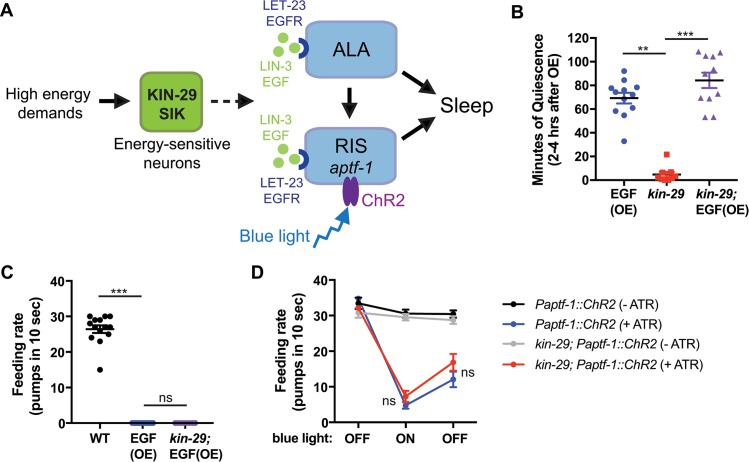
kin-29 acts upstream of ALA and RIS neurons to regulate sleep.(A) Model by which kin-29/SIK functions in energy-sensitive sensory neurons upstream of the sleep-promoting RIS and ALA neurons. ALA and RIS activation by LIN-3/EGF or RIS activation by ChR2 bypasses the requirement for KIN-29 function in sleep. RIS is also required for movement quiescence during SIS (see S11C–S11F Fig and [43]). (B and C) kin-29 null mutation does not affect the body movement quiescence (B) and reduced feeding rate (C) observed in response to EGF OE (n > 10 animals). To induce EGF OE, adult animals expressing a Phsp-16.2::LIN-3C transgene were heat-shocked for 30 min, 2 hr prior to analysis of behavior (see Material and methods). Data are represented as mean ± SEM. *** and ** indicate corrected p-values that are different from WT or kin-29 mutants at p < 0.001 and p < 0.01, respectively, by a Kruskal-Wallis with Dunn multiple-comparisons test (S1 Data, Sheet 6B and 6C). (D) Optogenetic stimulation of the RIS neuron causes a reduction in feeding rate, which is not dependent on kin-29. WT and kin-29 null mutants expressing Paptf-1::ChR2 grown either in the presence or absence of ATR were exposed to blue light (ON) (see Material and methods). Pumps were counted during a 10-s window, before, during, and after exposure of transgenic animals (n = 9–13) to blue light. Data are represented as the mean ± SEM for each condition. ns indicates values that are not different between WT Paptf-1::ChR2 (+ATR) and kin-29; Paptf-1::ChR2 (+ATR) by an ANOVA with Tukey multiple-comparisons test S1 Data, Sheet 6D). ATR, all-trans retinal; ChR2, channelrhodopsin2; EGF, epidermal growth factor; EGFR, EGF receptor; ns, not significant; OE, overexpression; SIK, salt-inducible kinase; SIS, sleep-induced stress; WT, wild type.